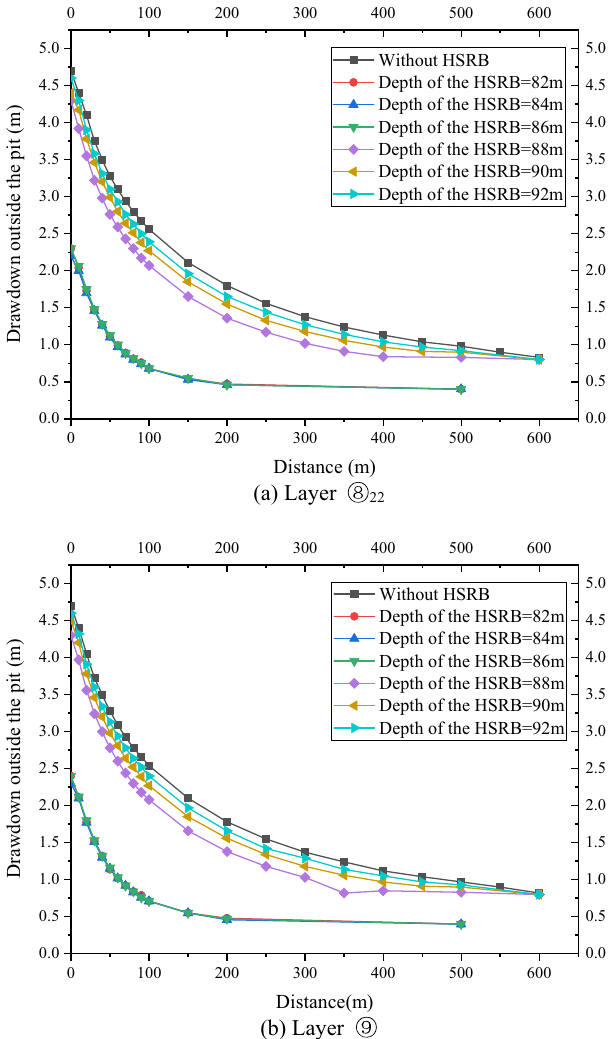
Figure 8. Drawdown–distance curve outside the pit with different HSRB